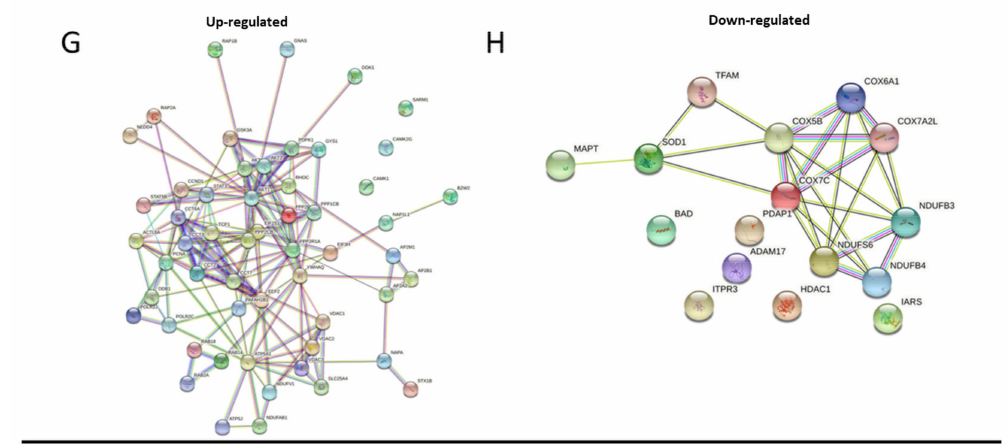
Figure 5. Effect of mc-FAs on ceramide/hexosylceramide and sphingomyelin/hexosylceramide ratios for 34:1, 40:2, 42:1 and 42:2 species. ( A , B ) Healthy controls; ( C,D ) VLCADD fibroblasts; ( E,F ) LCHADD fibroblasts. ( G , H ) Up- and down-regulated LCHADD protein network after incubation with C7 identified via STRING software (http://www.string-db.org/; 12 May 2021). Values denoted by * were considered significant if p < 0.05, ** p < 0.005, *** p < 0.0005, **** p < 0.0001 (two way ANOVA, genotype and diet were used as independent factors; Mann-Whitney test, Friedman test and Tukey’s Test); * indicates significant differences between healthy controls and